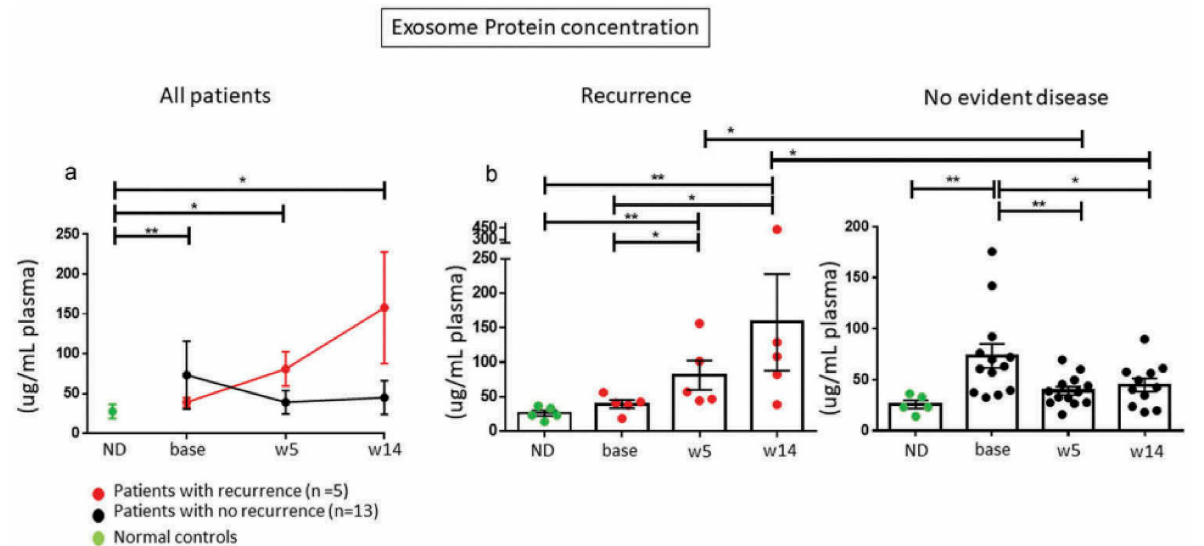
Figure 5. Changes in plasma exosomes (shown as total sEV protein level) of HNSCC patients treated with cetux- imab/IMRT/ipilimumab. Five patients had recurrence and 13 were NED at 2 yrs. after therapy. Note decreased exosome protein in patients who remained NED for >2 yrs. * p = 0.05; ** p = 0.005. ND= normal donors. Reproduced from ref